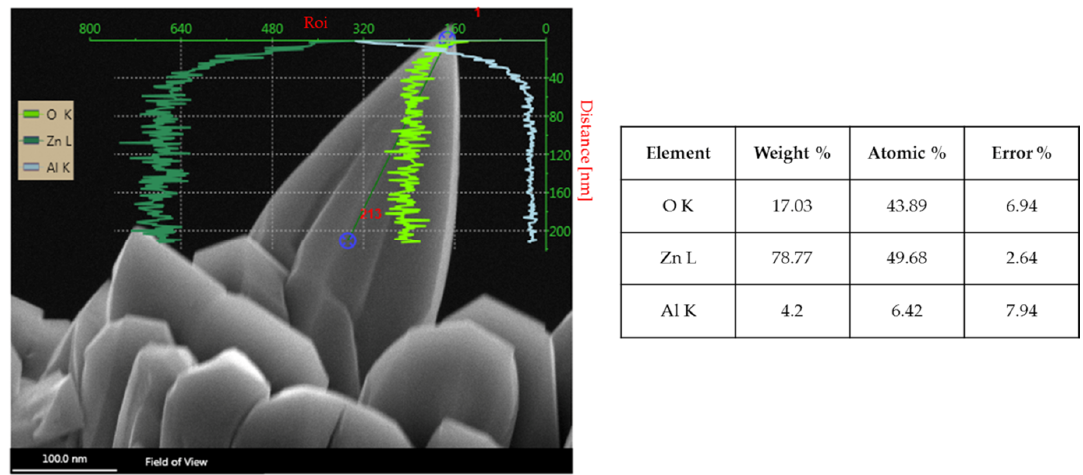
Figure 10. EDX line scan of a ZnO nanowhisker at the substrate edge grown in optimized conditions. The intensity profile reveals a constant ratio of Zn and O in 1:1 stoichiometry along the nanowhiskers axis. The aluminum originates from the sample